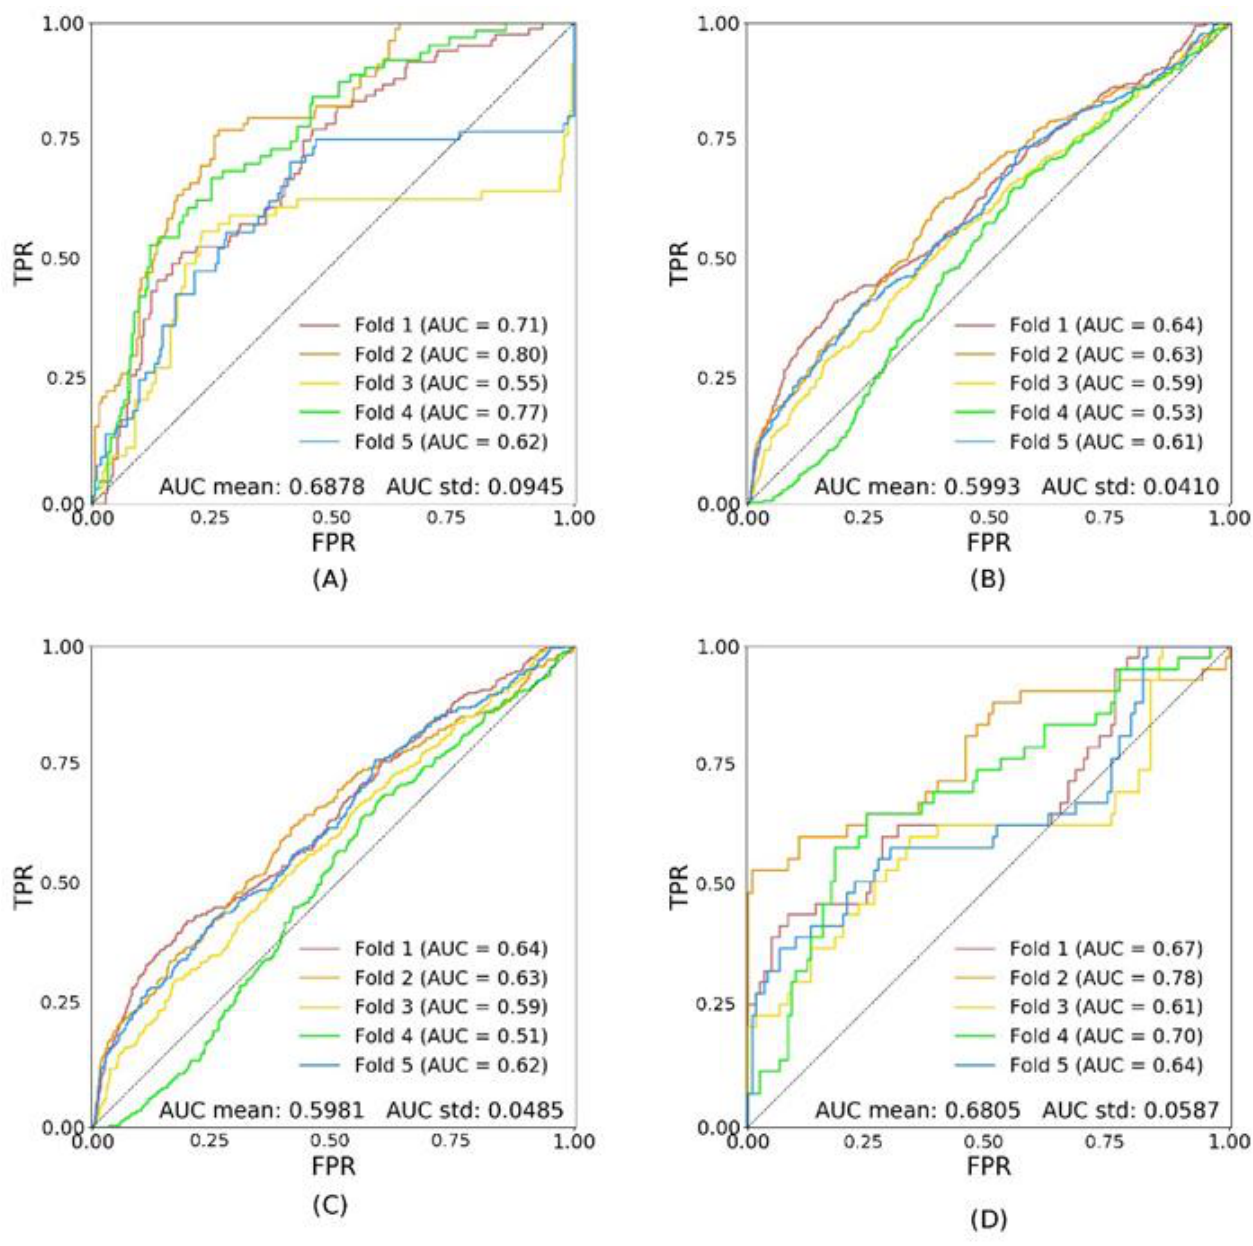
Figure 4. Shows the performance of the model trDR+ (trained on patients with DR). Image ( A ) shows the ROC curves for the validation set (val); ( B ) shows the ROC curves for the test set with all patients (tsA); ( C ) shows the ROC curves for the test set with patients without DR only (tsDR−); ( D ) shows the ROC curves for the test set with patients with DR only (tsDR+).